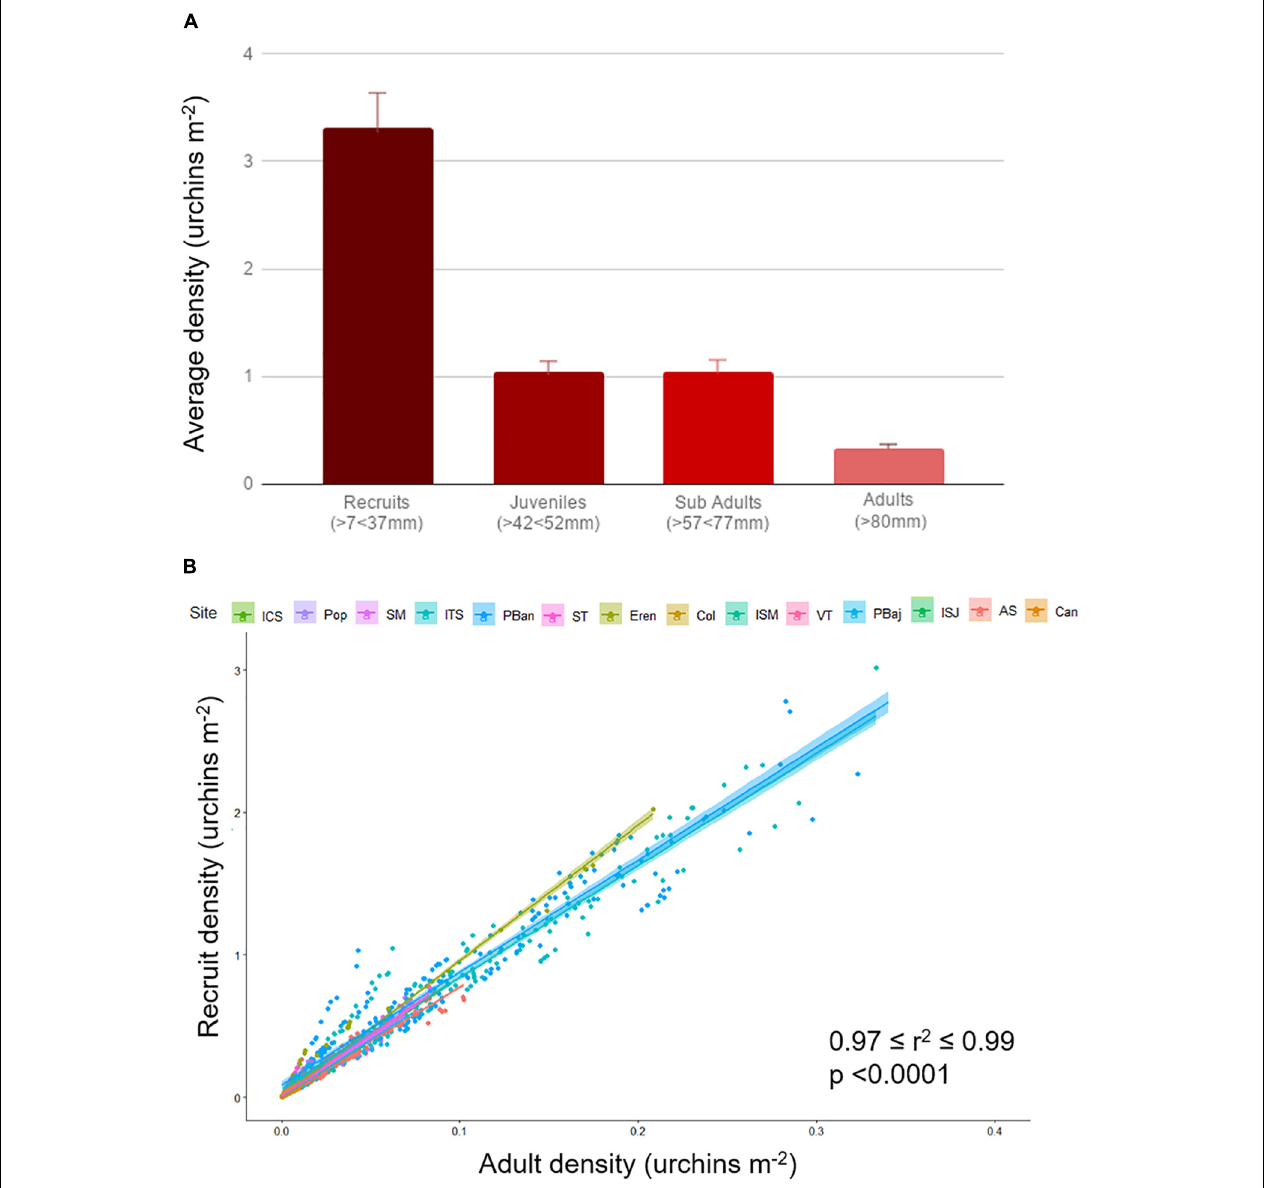
FIGURE 6 | Average red sea urchin density ( ± SE) estimated by size class, 19-year data pooled (A) . Recruits (7–37 mm), juvenile (42–52 mm), sub-adults (57–77 mm), and adults ( > 80 mm). Red sea urchin adult and recruit density relation per site (B) . Data for each site contains all time series; color shade represents 95% confidence